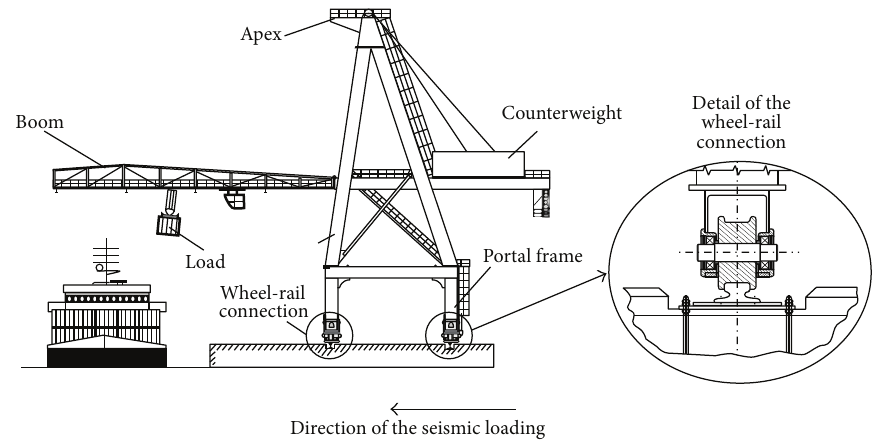
Figure 2: Schematic model of the container crane with the direction of seismic loading.